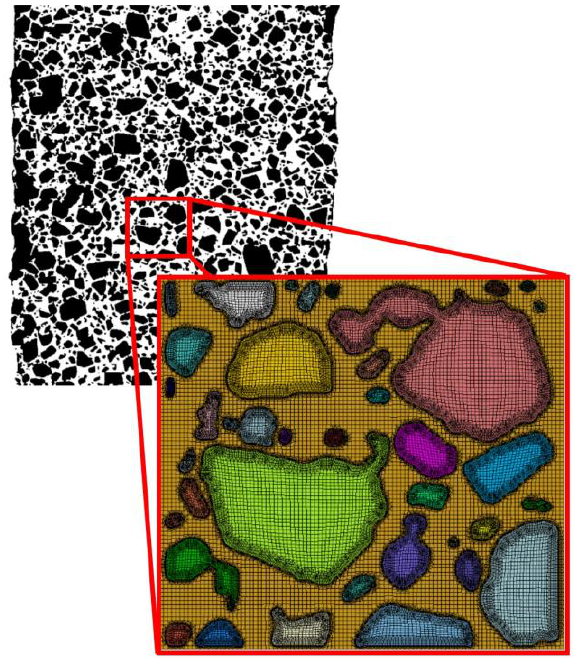
Figure 9. Binary image of CF75L with inset detail of the element mesh used in preliminary simulations.